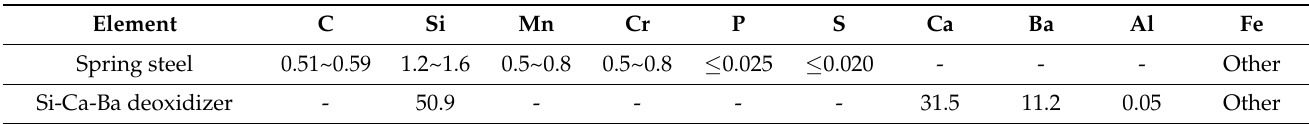
Table 2. Weight of raw materials added in the experiment/g.